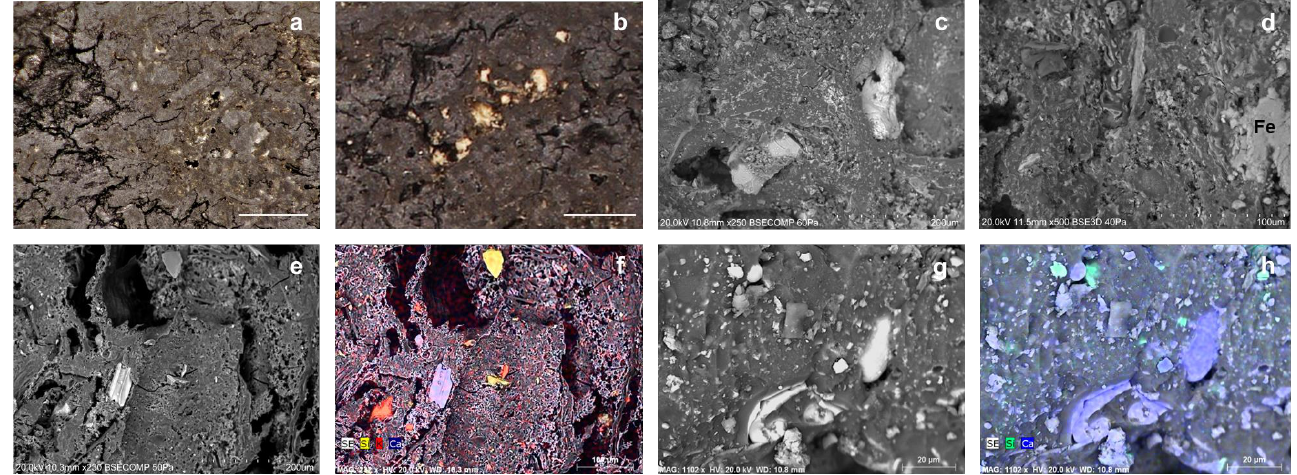
Figure 4. Micrographic and elemental analysis of the carbonized faeces. ( a – d ): Visible porosity and inclusions; ( e – h ): elemental mapping showing calcium-rich and silicon-rich inclusions. inclusions; ( e – h ): elemental mapping showing calcium-rich and silicon-rich